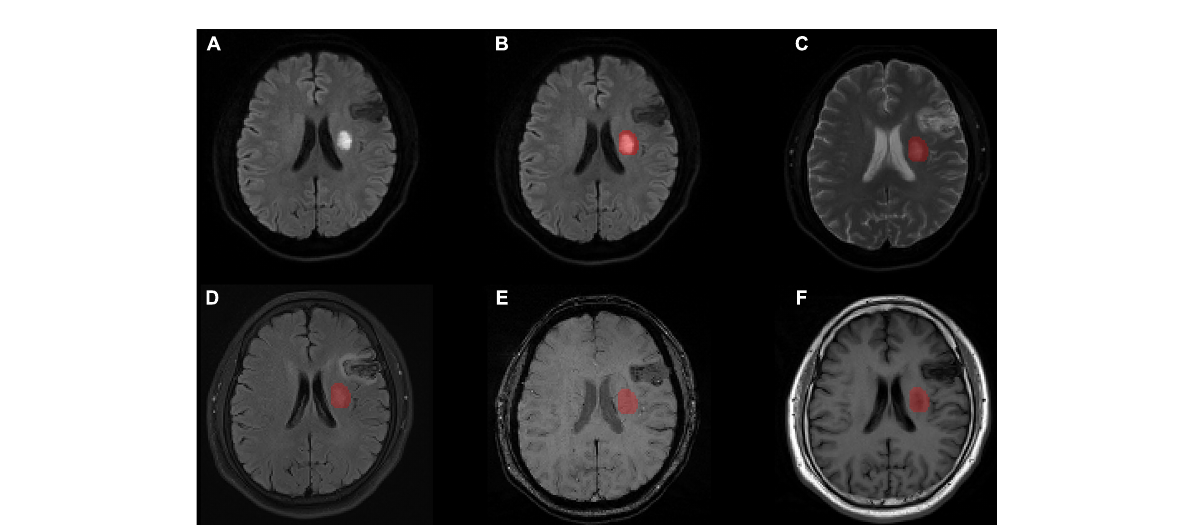
FIGURE2 Lesion segmentation results for one patient with manual outlining of the lesion using MRIcron on (A) the original DWI image, (B) the lesion superimposed onto the DWI image, (C) the lesion superimposed onto the ADC image, (D) the lesion superimposed onto the FLAIR image aligned to the DWI image, (E) the lesion superimposed onto the SWI image aligned to the DWI image, and (F) the lesion superimposed onto the T1w image aligned to the DWI image. MRI, magnetic resonance imaging; ADC, apparent diffusion coefficient; DWI, diffusion-weighted imaging; FLAIR, fluid attenuated inversion recovery; SWI, susceptibility weighted imaging; T1w, T1-weighted.